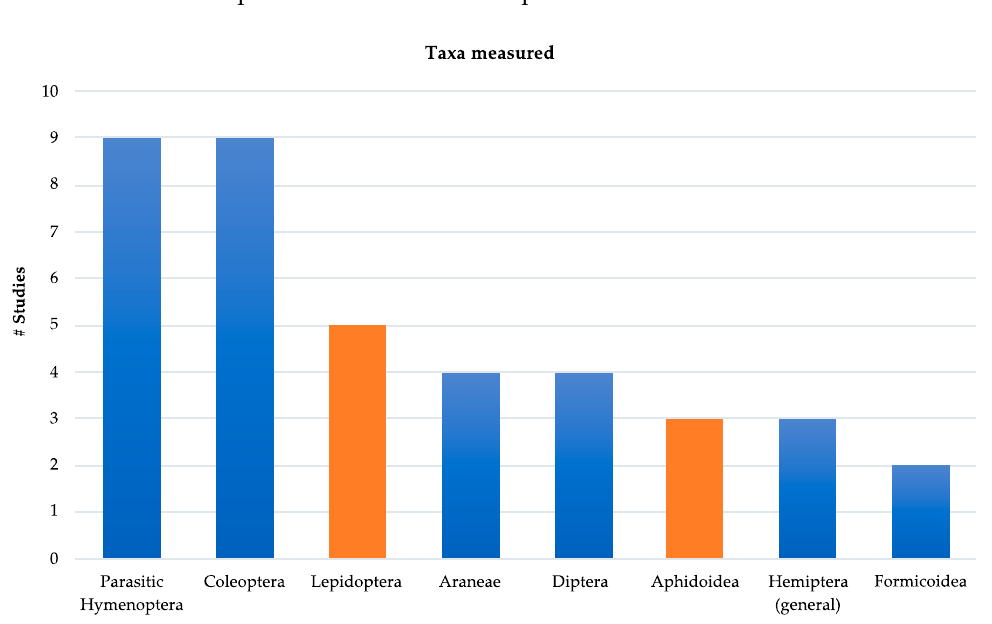
Figure 1. Number of taxa studied in the reviewed published literature. Height of the bar represents the number of studies for each taxa. Blue coloration represents predator or parasitoid groups, orange represents pest groups considered in each study.